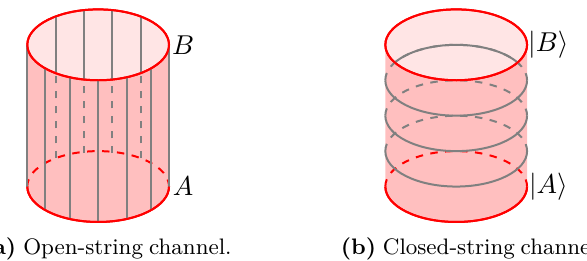
Figure 2. The slicings of the cylinder corresponding to the (a) open-string and (b) closed-string channels. In (a), the cylinder is sliced into intervals along the periodic coordinate, and so the partition function is thermal. In (b), the boundary conditions represent initial and final states belonging to a CFT quantized on the